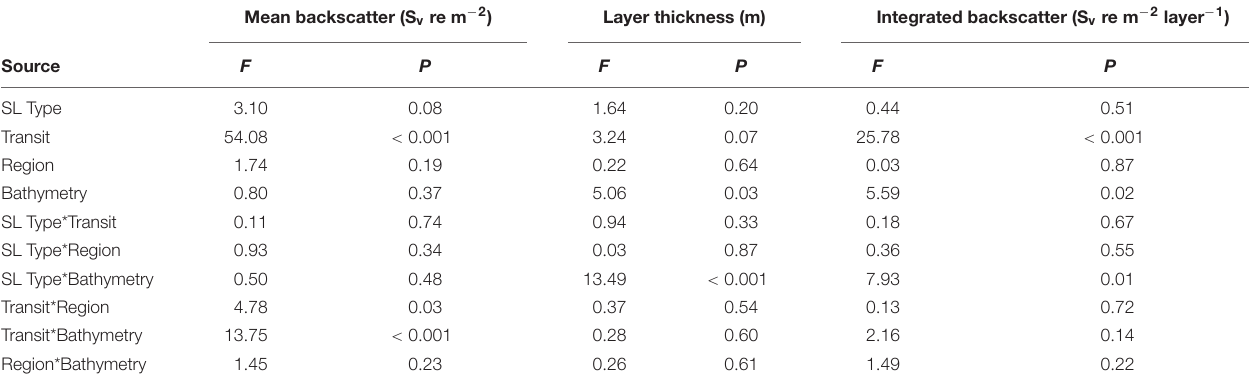
TABLE 3 | ANOVA summary with F-statistics and probability values for three descriptive metrics of shallow and deep SL types for factors of SL type, across-shelf region, bathymetric region, and glider